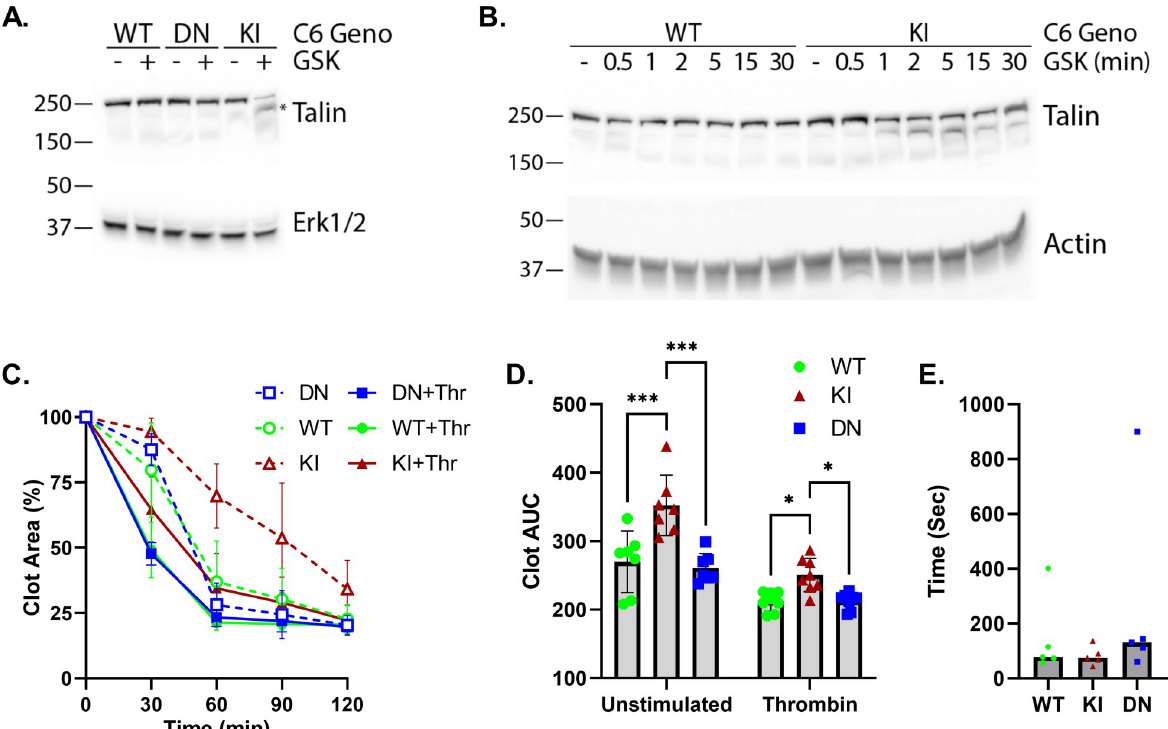
Fig 5. Effect of Trpc6 genotype on talin cleavage, clot retraction and tail bleeding times. A, western blot analysis of platelet lysates of the indicated Trpc6 genotype treated with or without GSK for 5 minutes. Lysates were probed for Talin (top) and Erk1/2 (bottom). The � points out the lower molecular weight Talin band corresponding to cleaved protein. B, time-course of Talin cleavage. WT and KI platelets were stimulated with GSK for the indicated time prior to lysis and western blot analysis. Actin served as a loading control. C-D, platelet-rich plasma (PRP) from WT, KI, and DN mice was incubated in the presence of extracellular calcium without or with thrombin stimulation. Clot area was calculated as a percentage of total sample area at various times. C, time course of clot area; n = 7–8 per group. D, clot area under the cure (AUC) was calculated by summing the clot areas across all time-points for each sample. Mixed-effects analysis with Tukey’s multiple comparisons test. E, tail bleeding times in mice with WT, KI and DN Trpc6 genotypes; n = 5 per group.